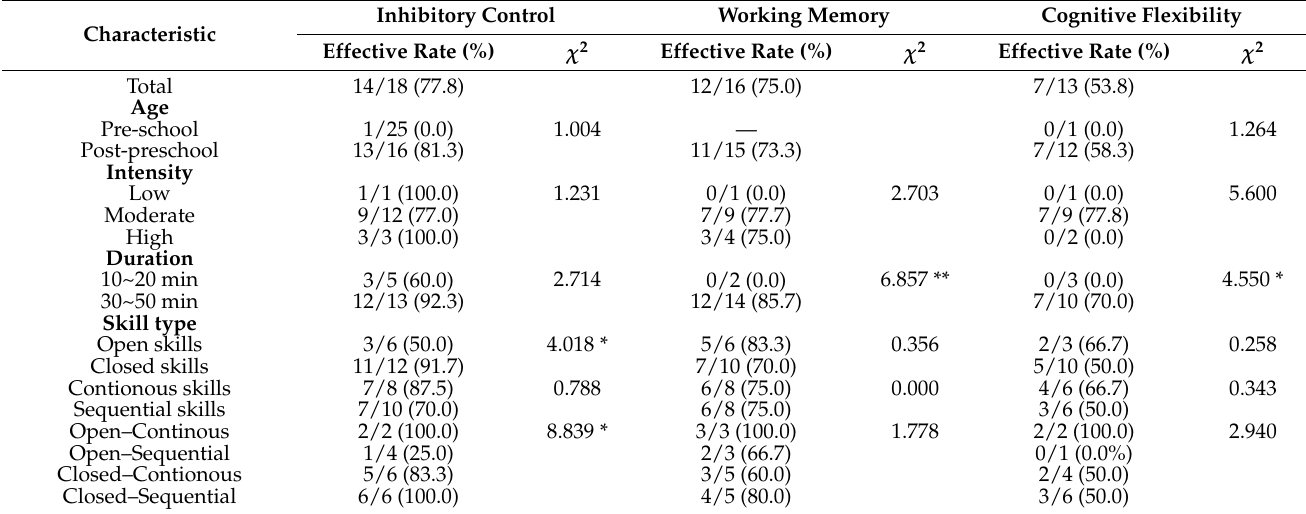
Table 4. Summary of intergroup comparisons of acute-intervention